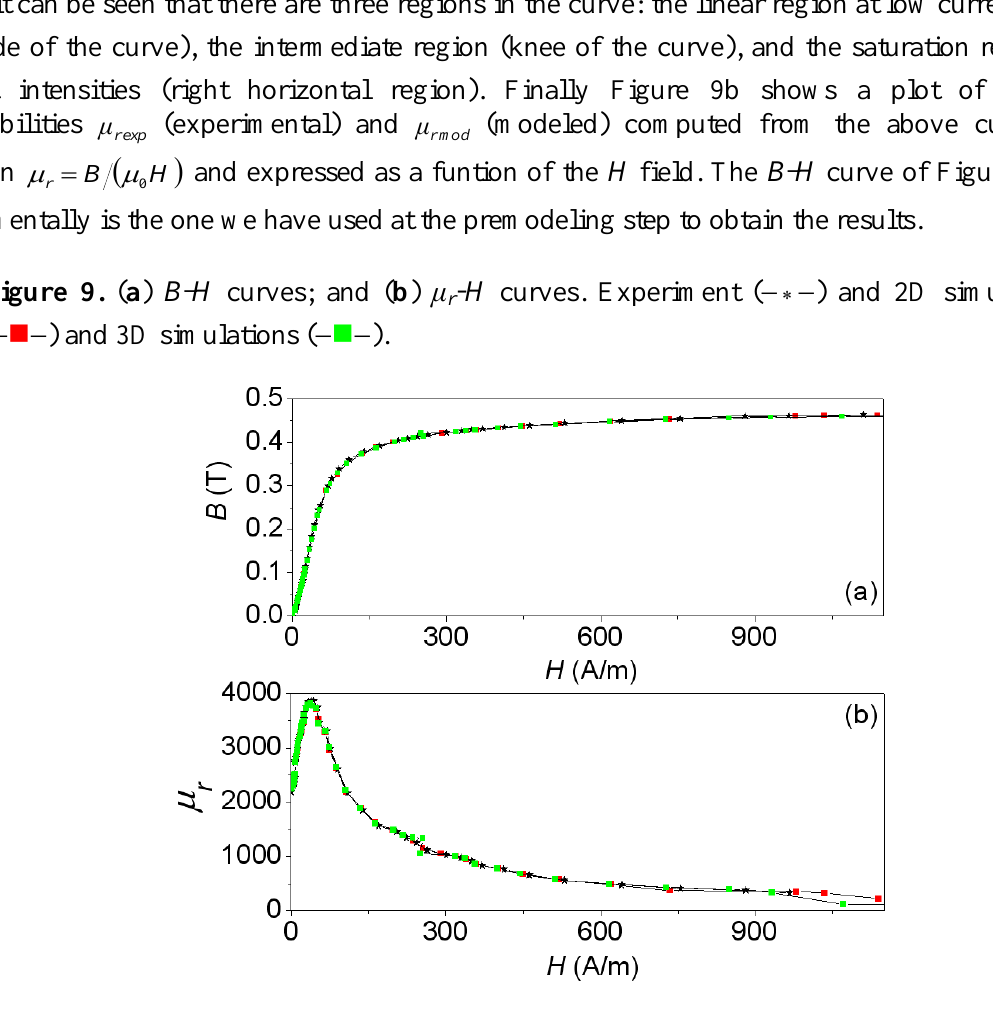
- H curves. Experiment (    ) and 2D simulations r